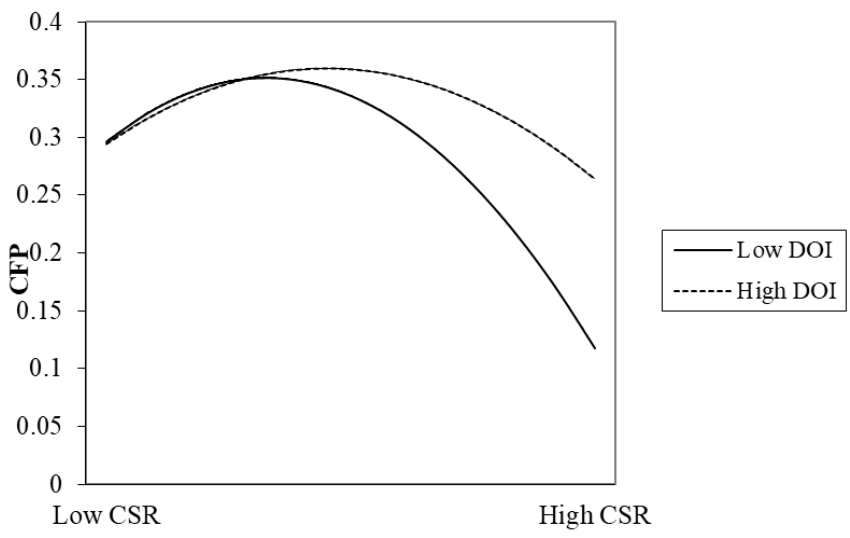
Figure 2. The U-shaped relationship between CSR and CFP, moderated by DOI.